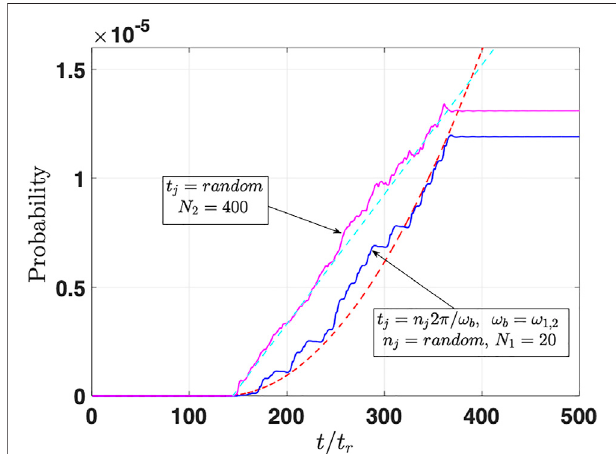
FIGURE 4 | Simulation results of the TLS upper-level probability buildup by electrons arriving to the interaction point at random (magenta) and by electrons arriving in-phase with the modulating laser (modulo the bunching period T b (cid:1) 2 π / ω b ) at the resonance condition ω 2 , 1 (cid:1) n ω b (blue). The lightblue-dashandred-dashcurvesarethelinearandquadraticcurve- fi ttings, respectively.